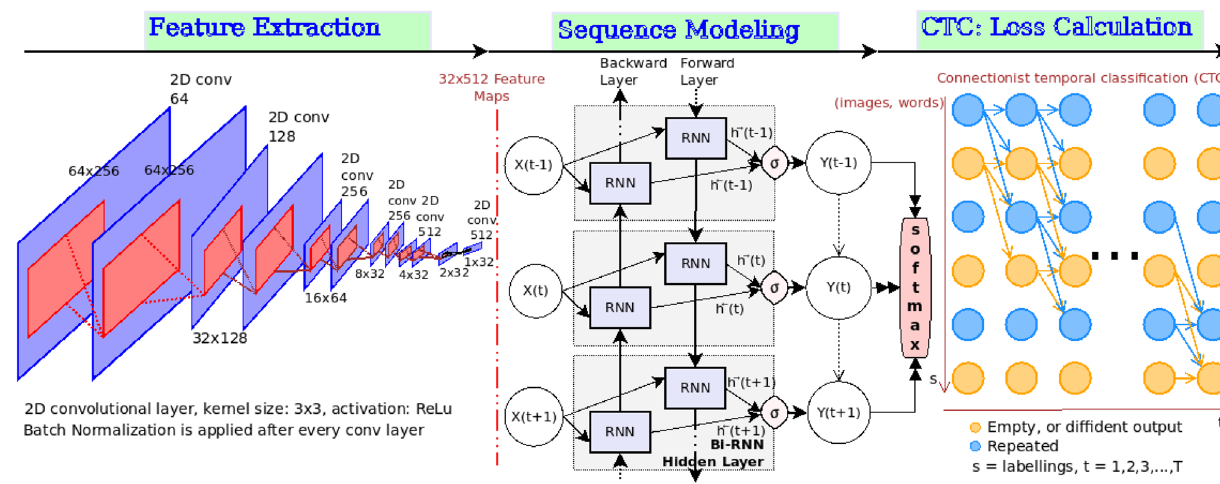
Fig. 2 General overview of the AHWR system used in this